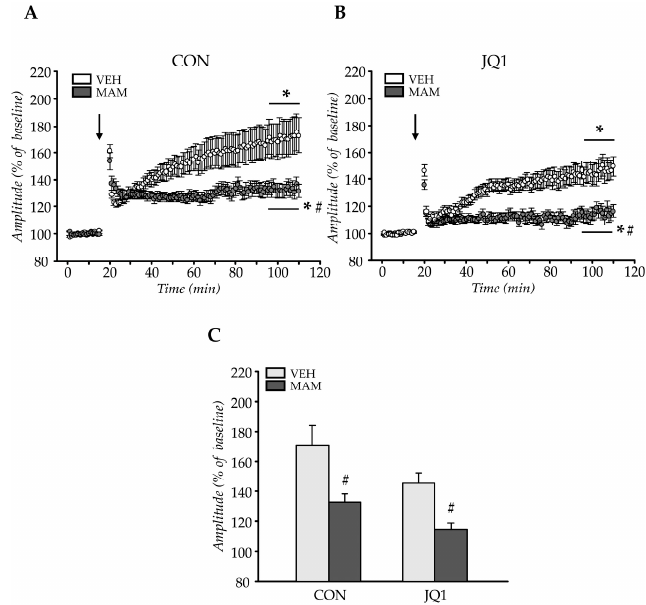
Figure 3. The effects of an adolescent JQ1 administration on long-term potentiation (LTP) in the male adult medial prefrontal cortex in the MAM-E17 model of schizophrenia. The rats were exposed to JQ1 or vehicle (CON) in early adolescence (P23–P29), and the analyses were performed in rats at P60–P110. The data are presented as group mean ± SEM, n = 12–17 (the number of brain sections from 6 to 9 animals). The data are expressed as percentage of the baseline amplitude values for each time point ( A – C ), C —the average of LTP during the last 15 min of recording. * p < 0.05 compared with the last 15 min of pre-tetanisation recording (for values averaged over the last 15 min of recording); # p < 0.05 compared with VEH-CON animals (for values averaged over the last 15 min of recording); two-way repeated measures ANOVA ( A , B ) or two-way ANOVA ( C ) followed by a Tukey test. Arrows indicate time of delivery of tetanic stimulation.